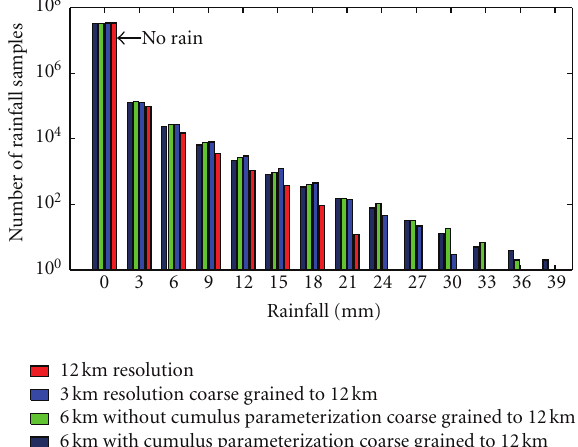
Figure 9: A comparative histogram with a 3mm bin width for the rainfall from the 12km, 6km with and without parameterization, and 3km runs. For the 6km and 3km runs, the data have been coarse grained to 12 km grid to facilitate a fair comparison to the 12km